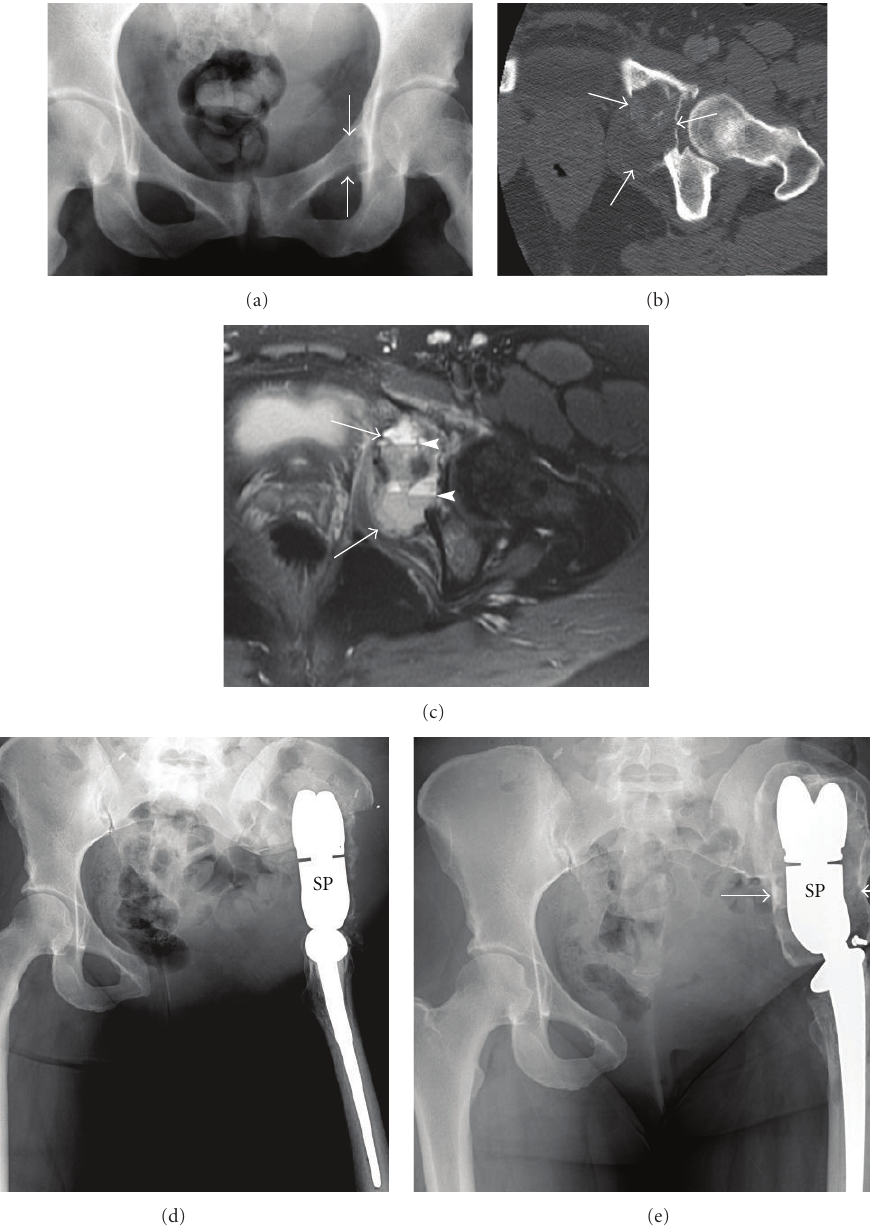
Figure 2: Osteolytic osteosarcoma. A 35-year-old female presenting with left hip pain diagnosed with aggressive lytic osteosarcoma. AP radiograph (a) demonstrates a subtle lytic lesion (arrows) in the left superior pubic ramus extending to involve the medial acetabulum. The extent of this predominantly lytic lesion with pockets of dense osteoid matrix is better appreciated on axial CT (arrows) (b). Axial T2 fat- saturated image (c) of the same lesion (arrows) depicts multiple fluid-fluid levels (arrowheads). The patient underwent left hemipelvectomy with placement of saddle prosthesis (SP) (d). A shell of heterotrophic ossification formed around the prosthesis (arrows) (e) is an expected finding, which helps stabilize the prosthesis and should not be misinterpreted as